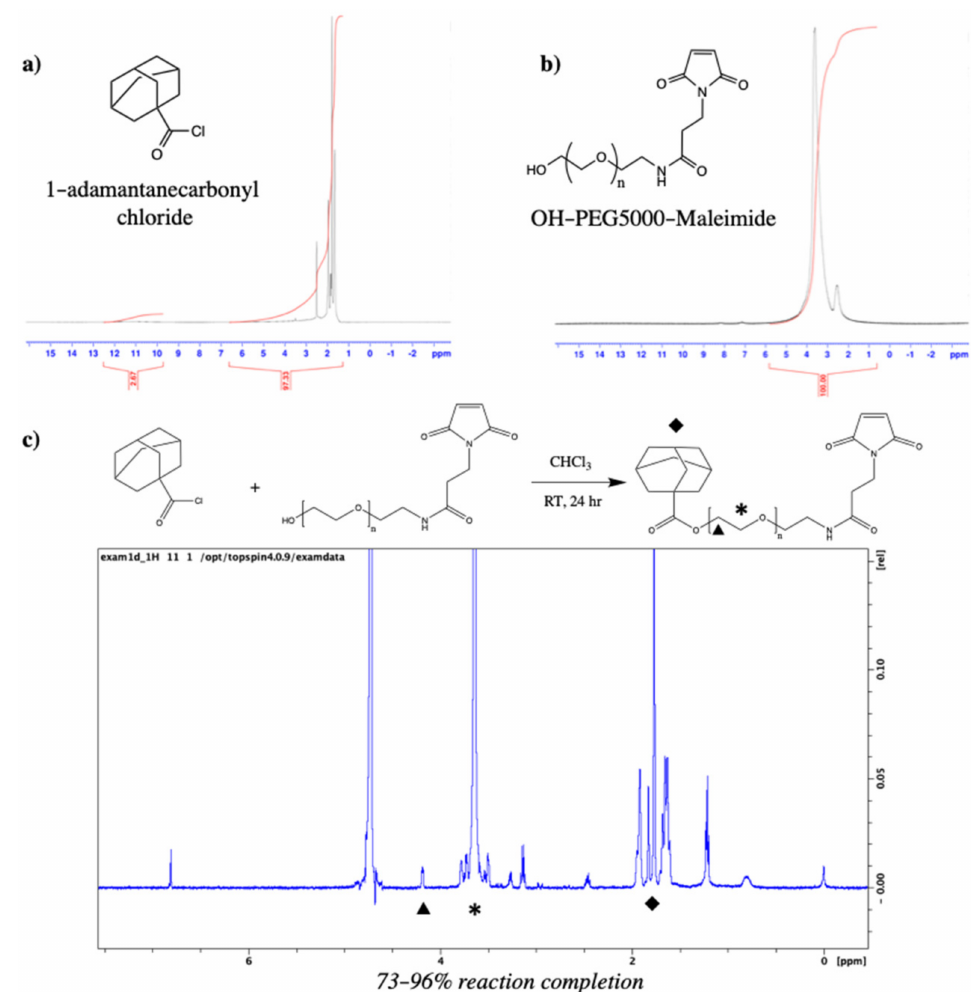
Figure 3. ( a ) 1 H NMR (DMSO- d 6 ) of 1-adamantanecarbonyl chloride which confirmed a 97.33% purity; ( b ) 1 H NMR (DMSO- d 6 ) of maleimide–PEG 5000 –hydroxyl; and ( c ) Ad–PEG 5000 –Mal 1 H NMR (DMSO- d 6 ), with unique peaks at δ = 1.7–1.9 ppm (Ad hydrocarbons, (cid:117) ), δ = 4.2 ppm (terminal − CH − of PEG, (cid:78) ), and δ = 3.6 ppm ( − CH − PEG repeat units, *). 2 2